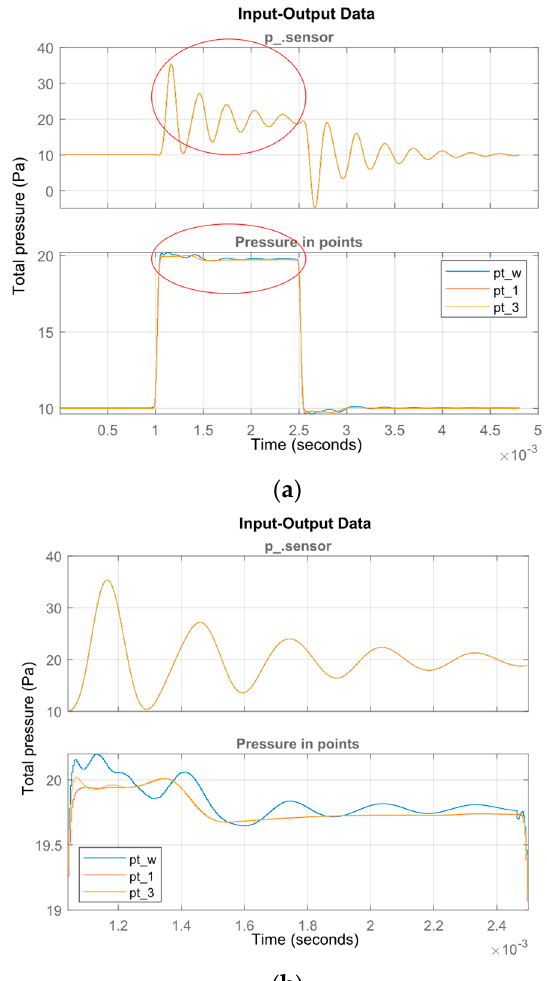
Figure 8. Waveforms of pressure changes at different points of the domain: full experiment ( a ), zoomed ‐ in view of the selected portion of the chart ( b ).